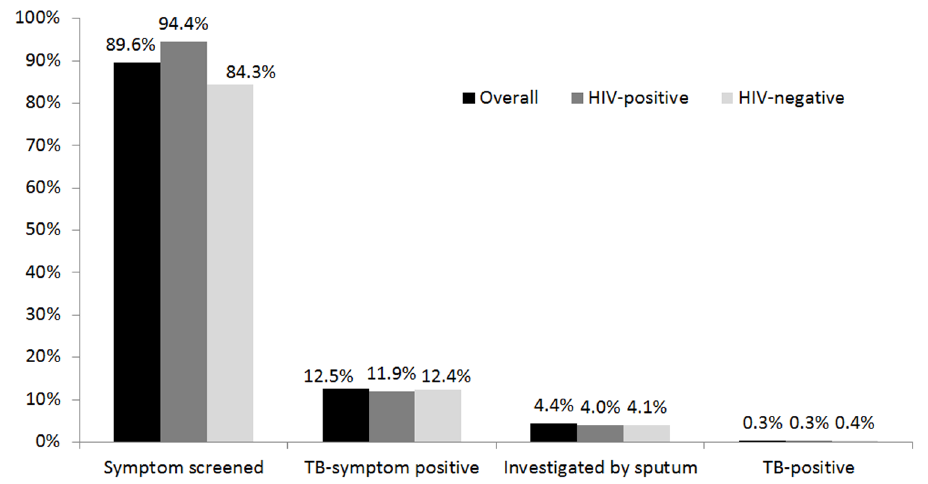
Figure 2. The TB screening cascade observed at 26,279 clinic visits at a primary care clinic in Johannesburg, South Africa. Black bars represent screenings in all clinic clients, dark grey bars represent screenings in HIV-positive clinic clients, and light grey bars represent screenings in HIV-negative clinic clients.